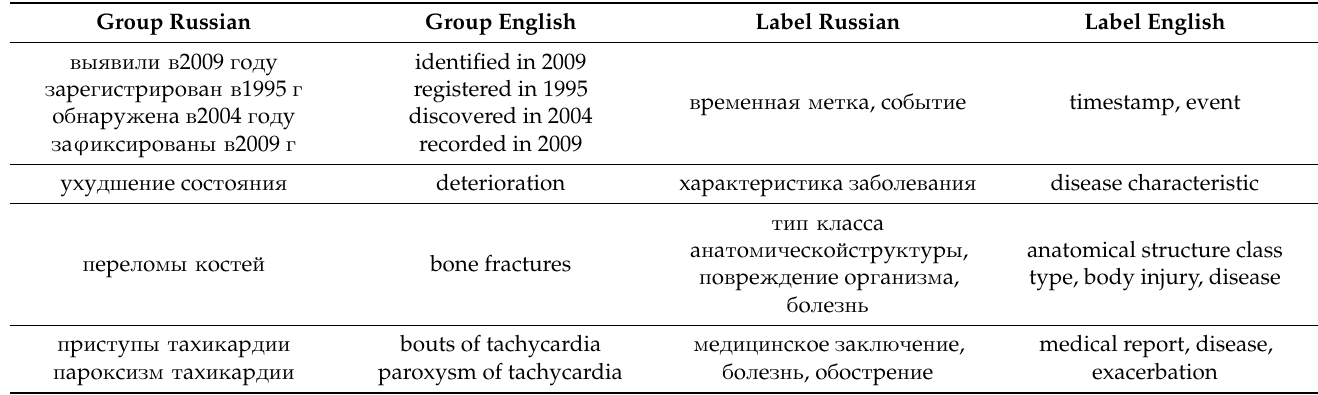
Table 3. Examples of labeled semantic groups.